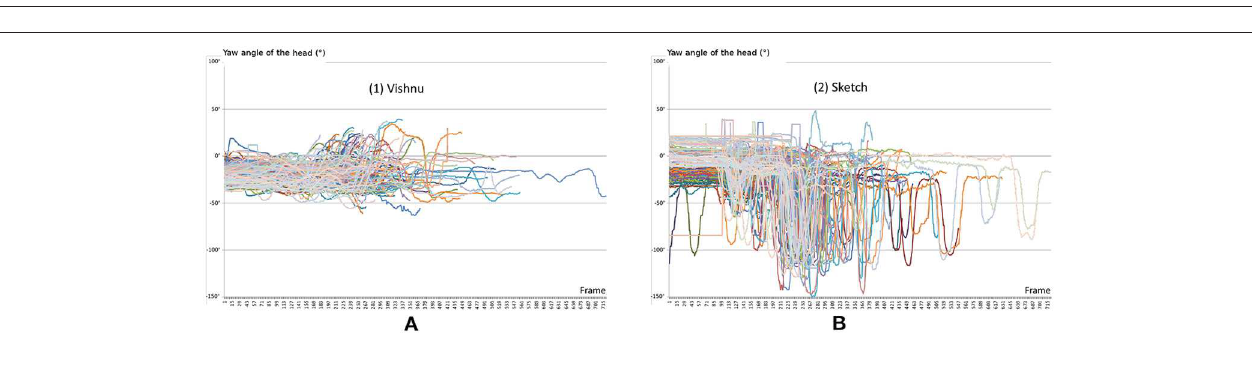
FIGURE 6 | (A) Yaw angle of the head for all iterations and all subjects for the Vishnu mode. (B) Yaw angle of the head for all iterations and all subjects for the Sketch mode. This illustrates the advantage of the fully collocated setup (mode 1) with a smaller range of 103 vs. 195 ◦ for mode (2). In sketch mode (2), we can identify of the movements of the subject’s head between the desktop screen and the real targets’